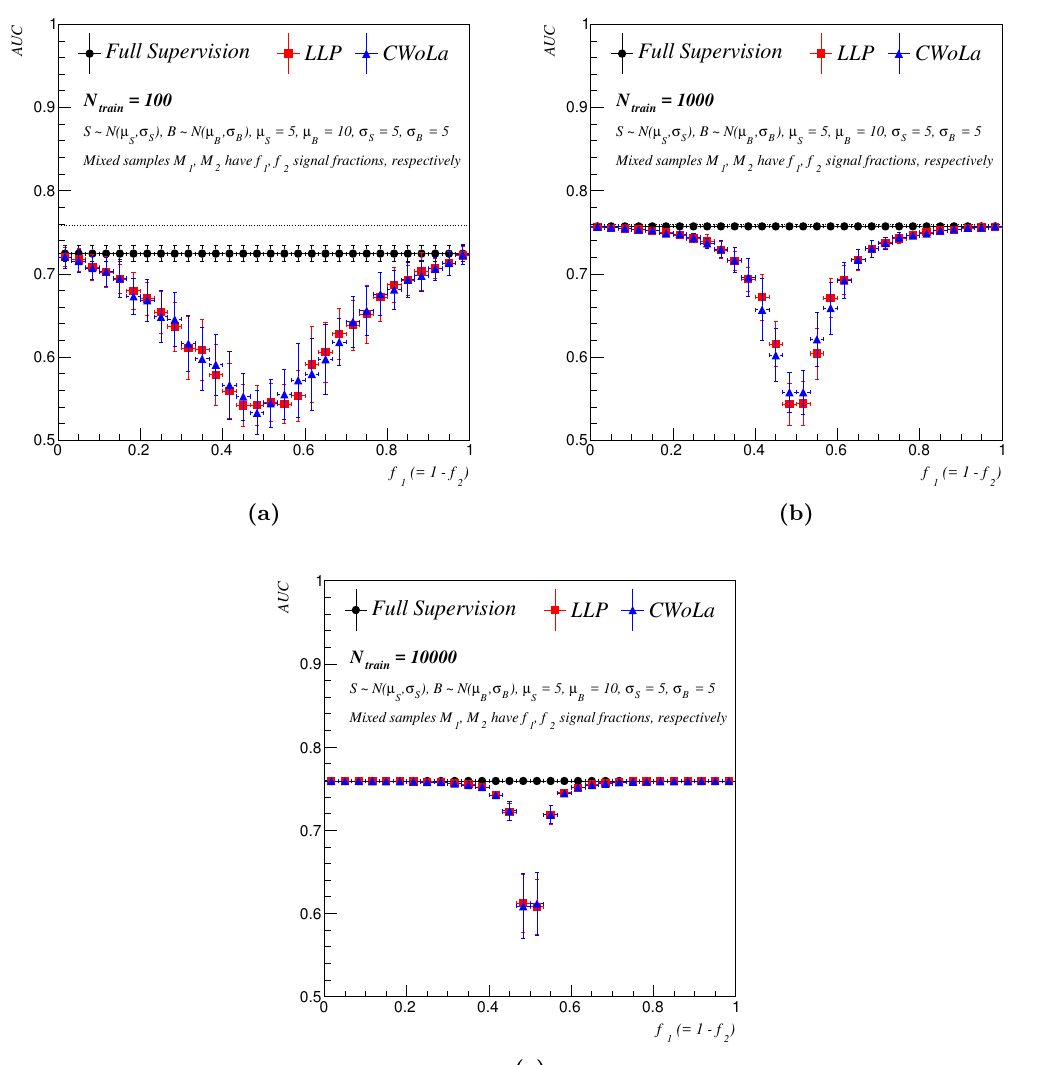
Figure 2 . The AUC for the LLP and CWoLa methods as a function of the signal fraction f training sizes N train of (a) 100 events, (b) 1k events, and (c) 10k events. Here, the complementary signal fraction is f 2 = 1 f 1 . By construction, the AUC for full supervision is independent of f 1 . (cid:0) The horizontal dashed line indicates the fully-supervised AUC with in(cid:12)nite training statistics. For N train su(cid:14)ciently large and f 1 su(cid:14)cient far from 0 : 5, all three methods converge to the optimal